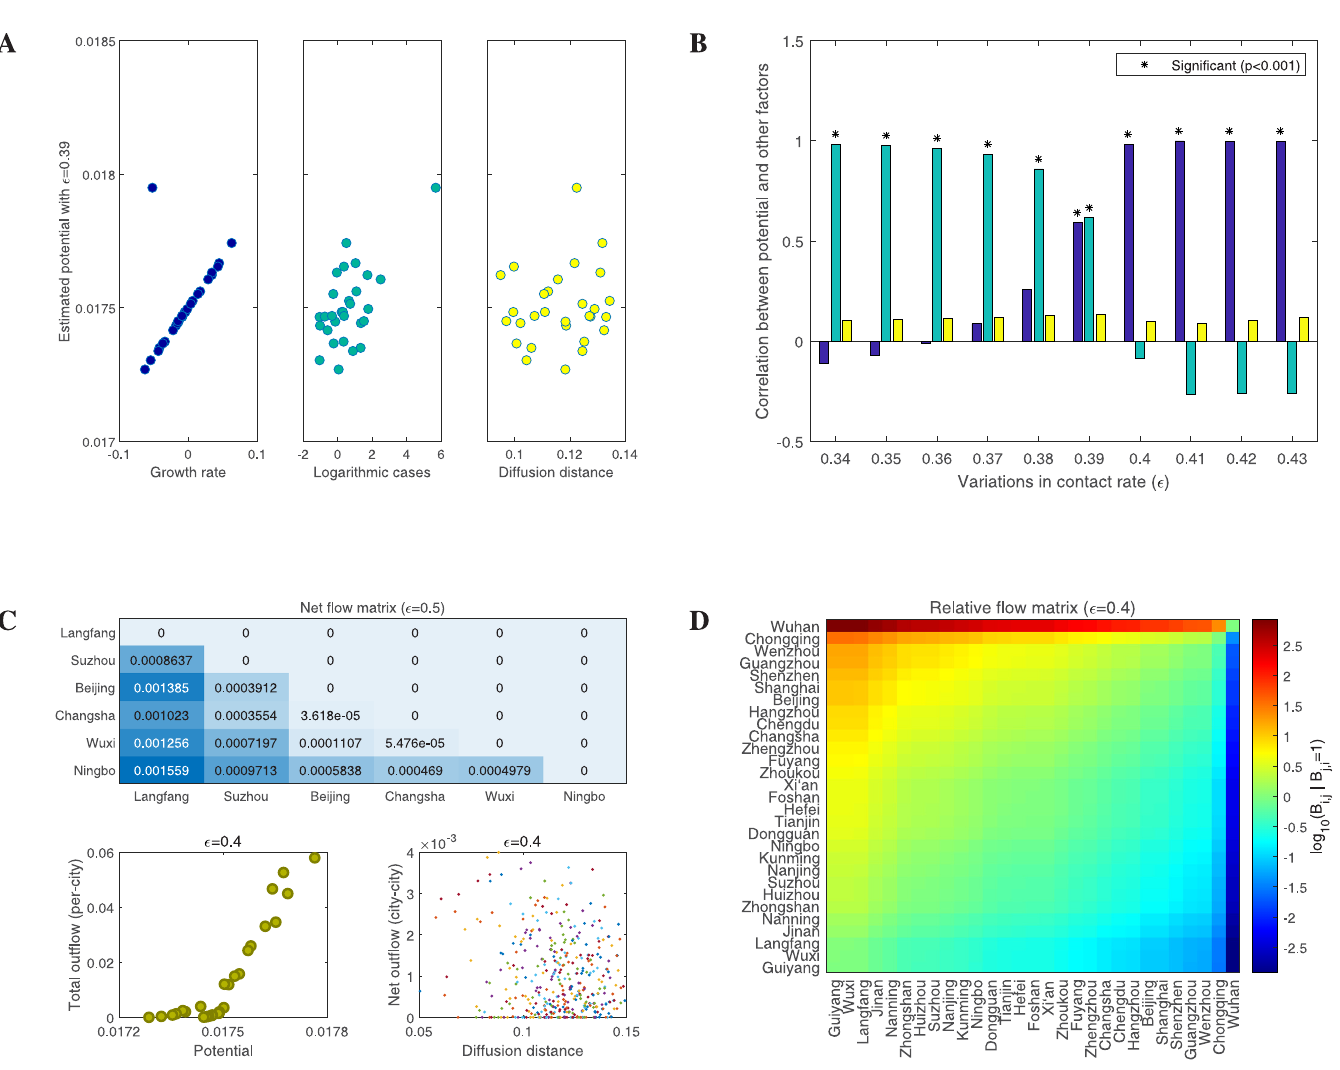
Fig 5. Estimated potential and flow matrices for the selected cities on February 6, 2020. A : The estimated potential versus growth rate, COVID-19 cases and diffusion distance. B : The correlation between estimated potential and other three factors (i.e., growth rate, COVID-19 cases and diffusion distance) which share the same color used in Fig A. C : The reconstructed net flow matrix, and the relationship between outflow and potential and diffusion distance, respectively. The value in each cell ( i , j ) of the net flow matrix represents the movement rate from city j to city i , where i is the row label and j is the column label. D : The relative flow matrix where the value in cell ( i , j ) is logarithmic travel flow from city j to city i under the condition that the travel flow from city i to city j is 1. The cities are ranked by numbers of COVID-19